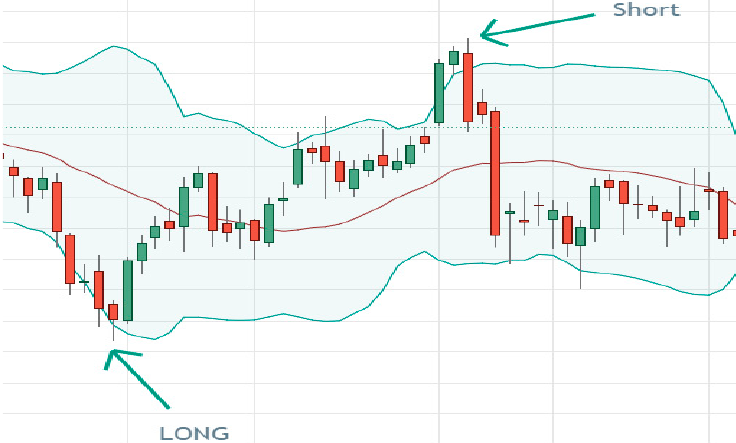
Figure 3. Bollinger Bands algorithmic trading strategy. Notes: A green daily candle means that the close price is above the opening price and a red candle means that the close price is lower than the opening price. The middle brown line is a simple moving average and the blue lines are the upper and lower boundaries of the BB.